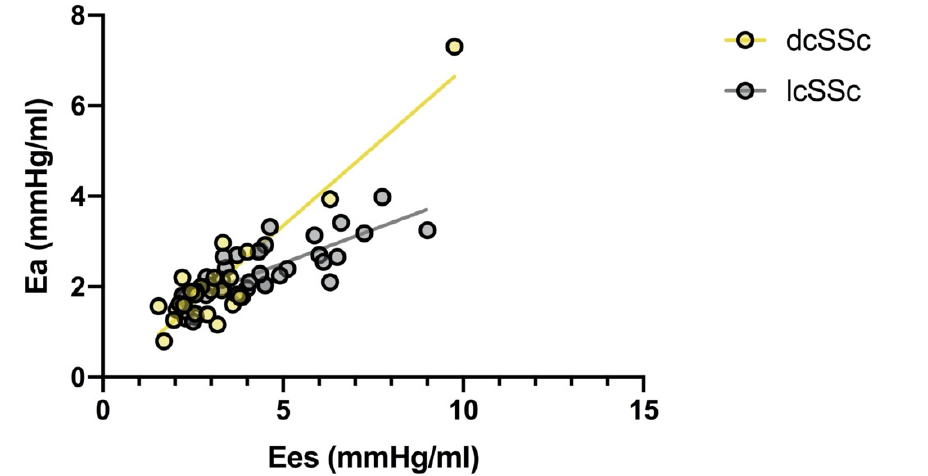
Figure 1. Scatterplot of the relationship between Ea and Ees in patients with lcSSc and patients with dcSSc. Ees correlates with Ea both in lcSSc ( ρ = 0.779, p < 0.0001) and, albeit more weakly, in dcSSc ( ρ = 0.599, p = 0.002).